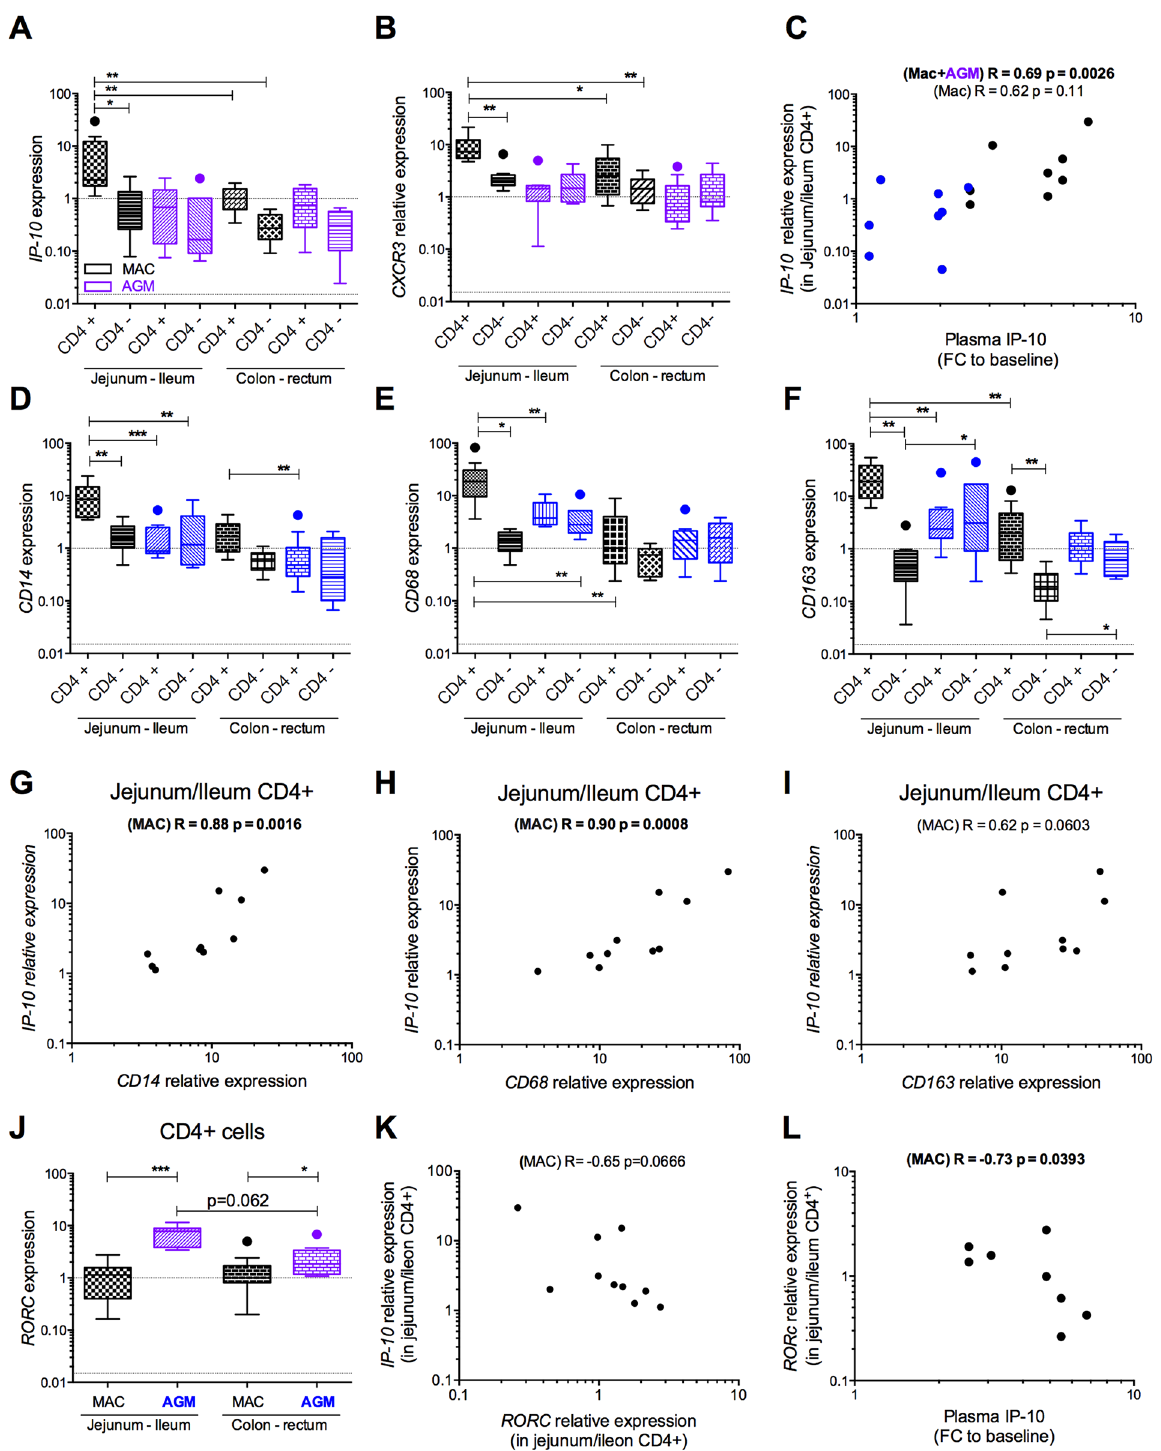
Fig 7. Cellular gene expression profiles in the intestine. A-L. Cellular gene expression levels were evaluated in CD4neg and CD4pos leukocytes from 4 distinct segments of the intestine of SIV+ non-human primates, i.e. rhesus macaques (n = 5) and African green monkeys (n = 5) on day 65 p.i. Raw values are represented. A . IP-10 gene expression. B. CXCR3 gene expression. C. Correlation between blood IP-10 levels and IP-10 gene expression in the upper intestine. IP-10 gene expression levels were normalized to expression in the rectum of each animal. IP-10 levels in blood are expressed as the fold change from baseline. ( D-F ) CD14 , CD68 and